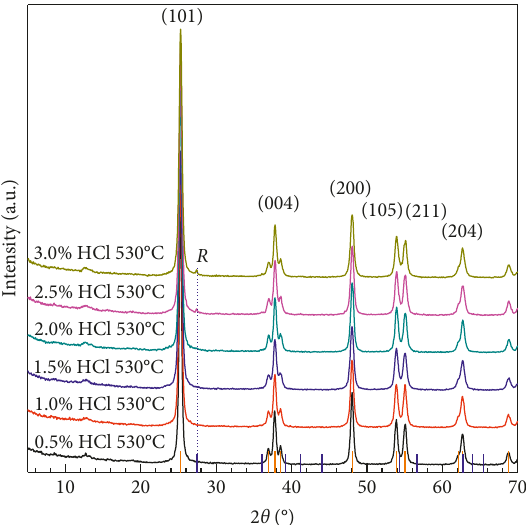
Figure 3: X-ray diffraction patterns of TiO 2m nanoparticles prepared at 530 ° C as a function of HCl Table 1: Crystallite diameter, pore size, surface area, and band gap E HCl% Crystallite size (v/v)